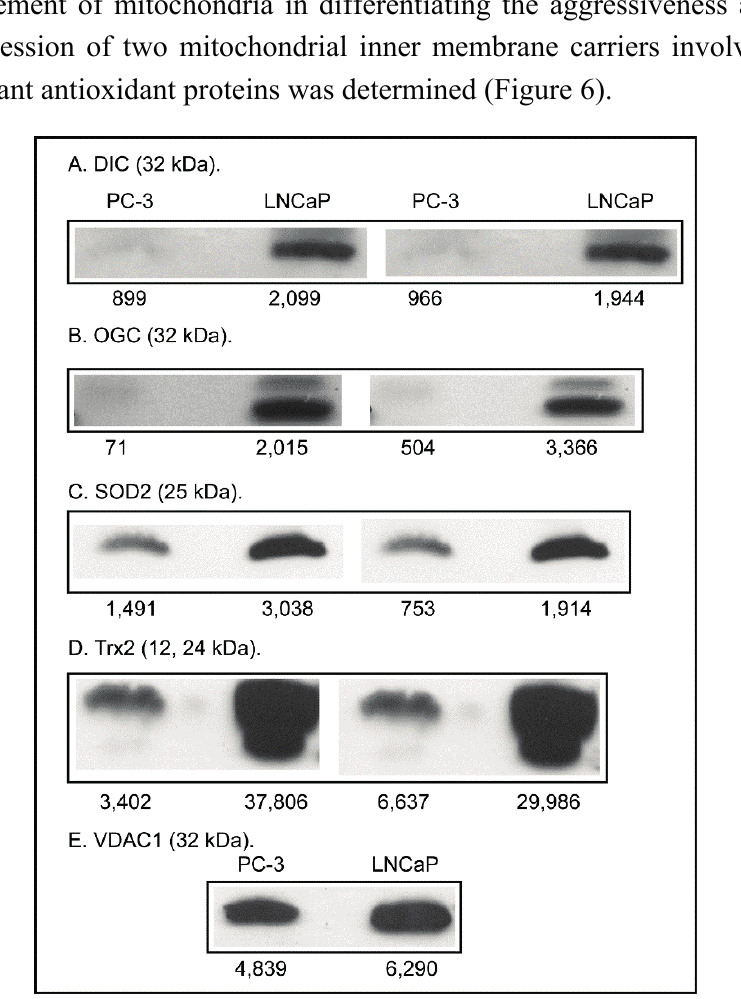
Figure 6. Western blot analysis of selected proteins of mitochondrial redox status .